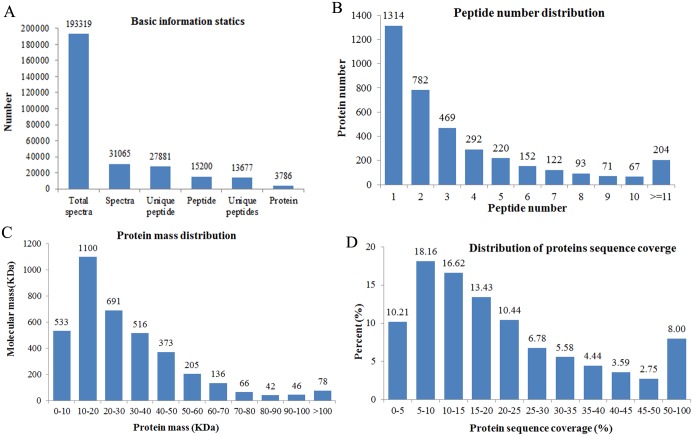
Identification and quantitative evaluation of identified proteins.(A) Spectra, peptides, and proteins identified using Mascot. (B) Number of peptides matching the proteins identified by using MASCOT. (C) Distribution of identified proteins according to different molecular masses. (D) Peptide coverage of the identified proteins.